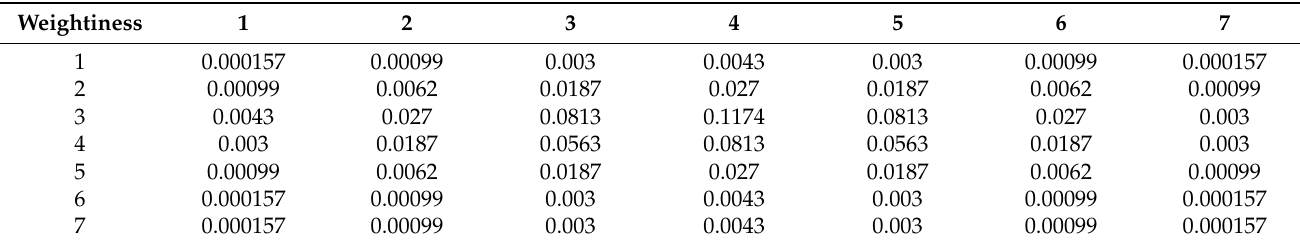
Table 2. Template of the weighted Gaussian